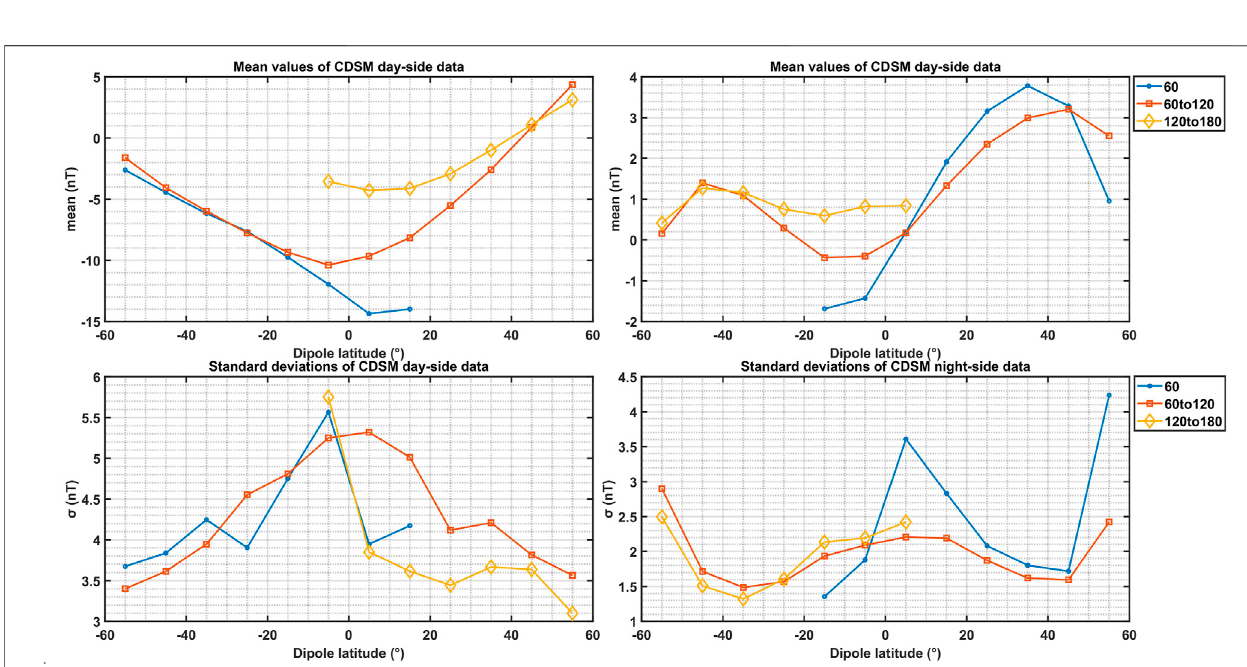
FIGURE10| Statisticalresultsofmeanvaluesandstandarddeviationsof Δ F from2September2019to29September2019withaspatialdistanceof10 ° ×10 ° and at increasing, non-overlapping time intervals of 60, 120, and 180 min.